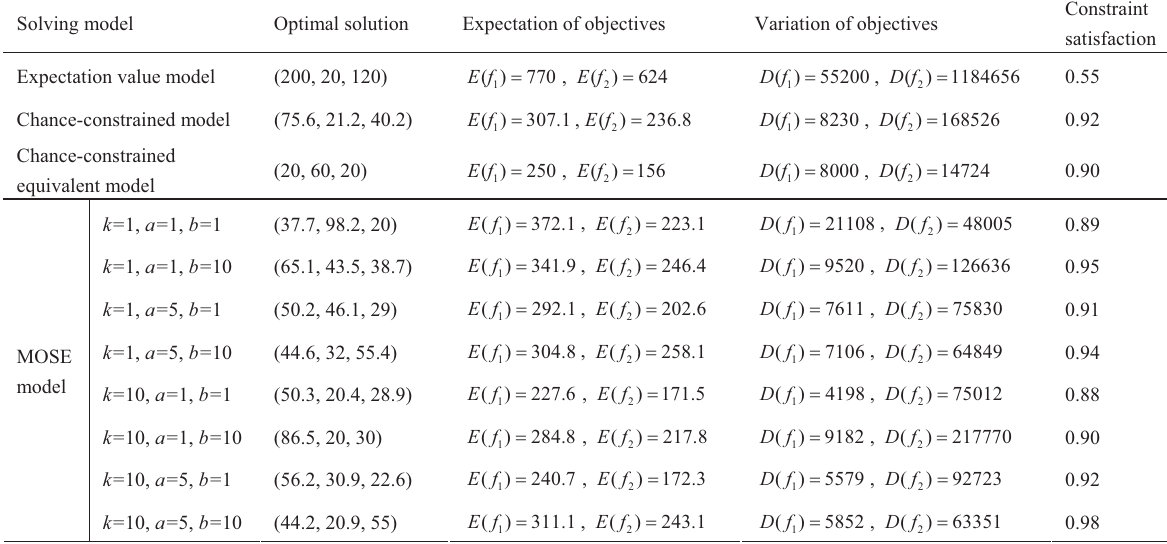
Table 3. The results for every method (